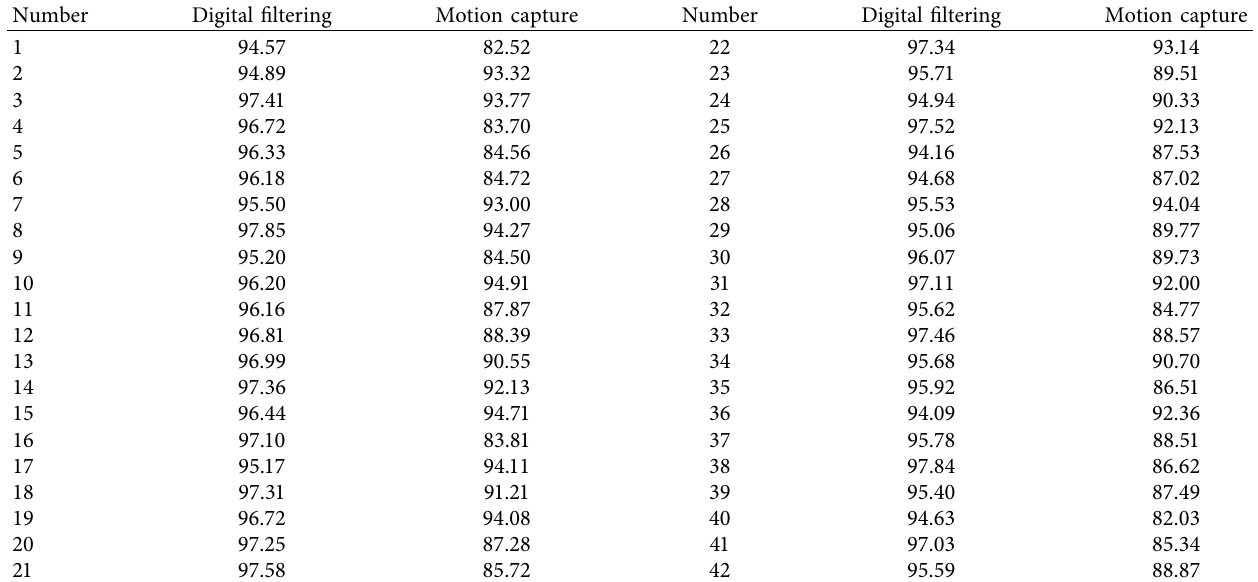
Table 1: System experiment